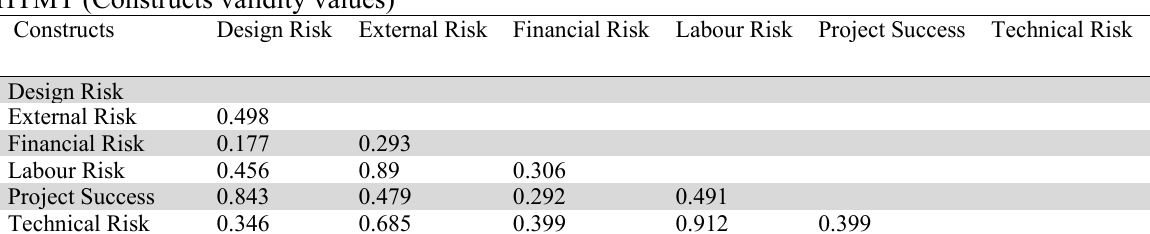
HTMT (Constructs validity values)